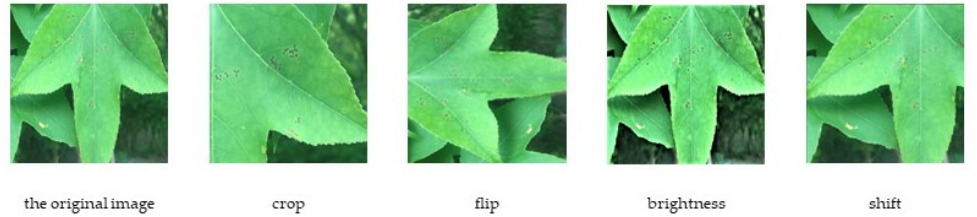
Figure 2. Data Enhancement.